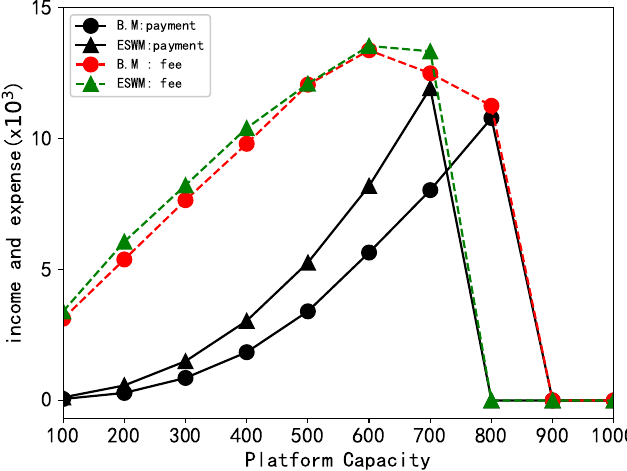
Figure 7. Comparison of income and expenses under different incentive